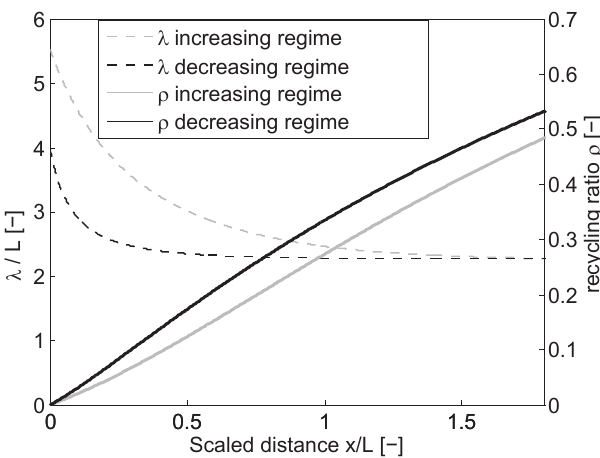
Fig. 8. Continental recycling ratio and recycling length scale λ(δx) (computed according to Eq. 46 relative to the moisture regime length scale L ) along x for the two regimes of Fig. 2 ( W 0 = 0 .